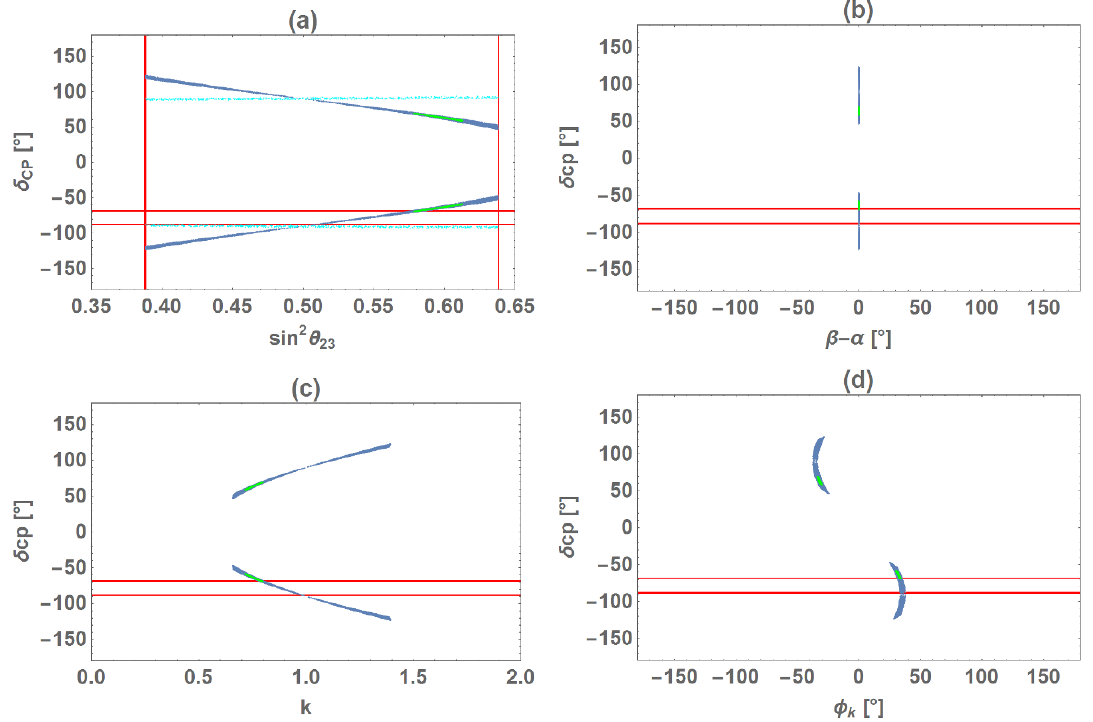
Figure 6 . Blue (green) dots denote predictions for TM 1 in IH with 3 (cid:27) (1 (cid:27) ). The red lines for sin 2 (cid:18) 23 and (cid:14) CP denote the experimental bounds of 3 (cid:27) (global analyses) and 2 (cid:27) (T2K) ranges, respectively: (a) (cid:14) CP versus sin 2 (cid:18) 23 , (b) (cid:14) CP versus di(cid:11)erence of two Majorana phases (cid:12) (cid:0) (cid:11) , (c) (cid:14) CP versus k , and (d) (cid:14) CP versus (cid:30) k . The cyan dots in (a) denote the prediction of the two-zero texture